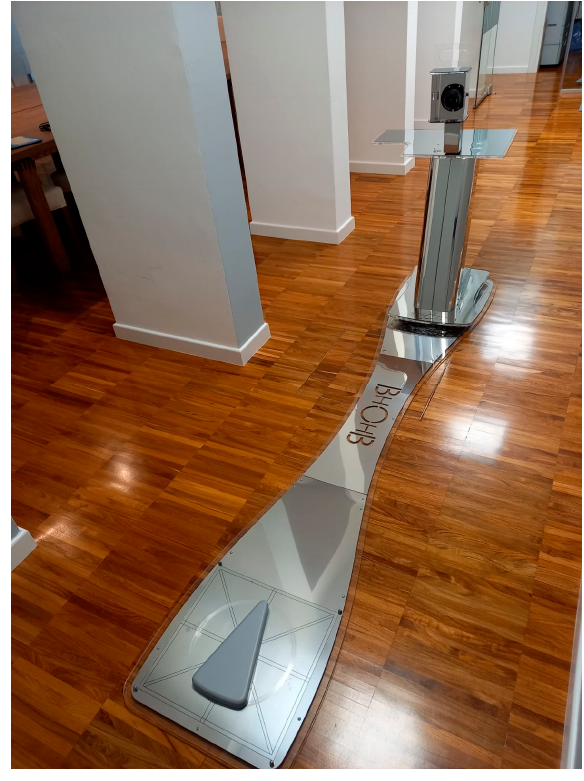
Figure 2. BHOHB platform.